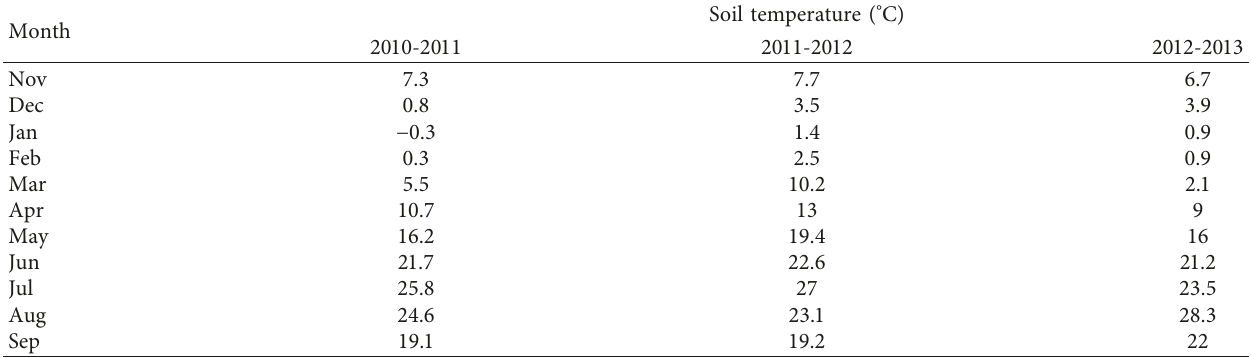
Table 1: Average monthly soil temperature obtained from a nearby automated weather station located at the Greenley Research Center near Novelty, MO, at the 6cm depth with soybean residue from the time of fall N application to corn harvest in each